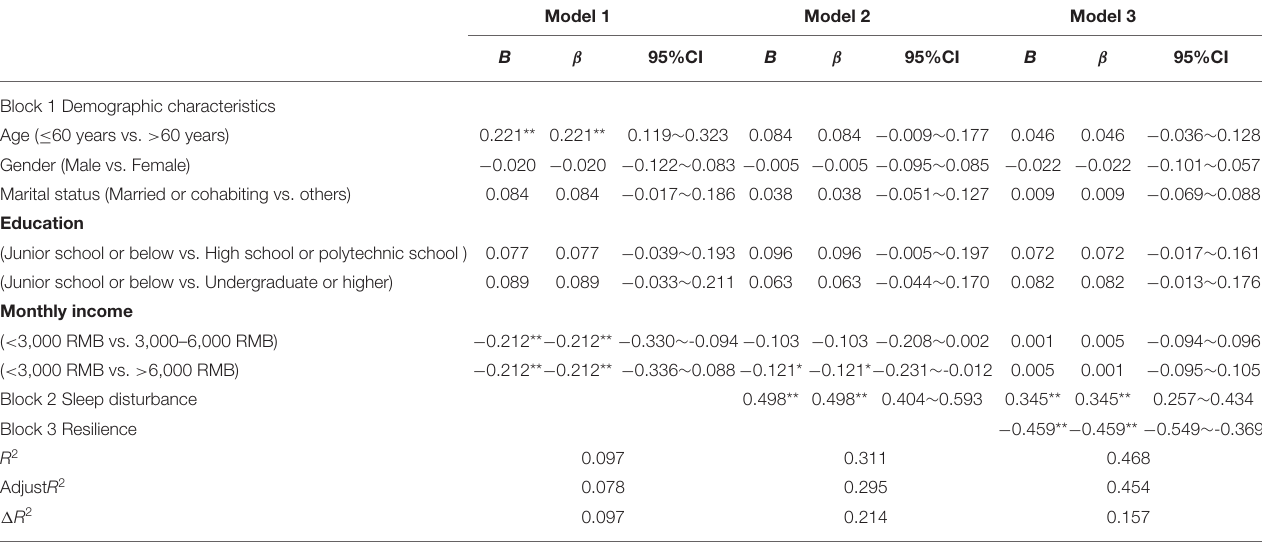
TABLE 3 | The hierarchical multiple regression models of PSD.